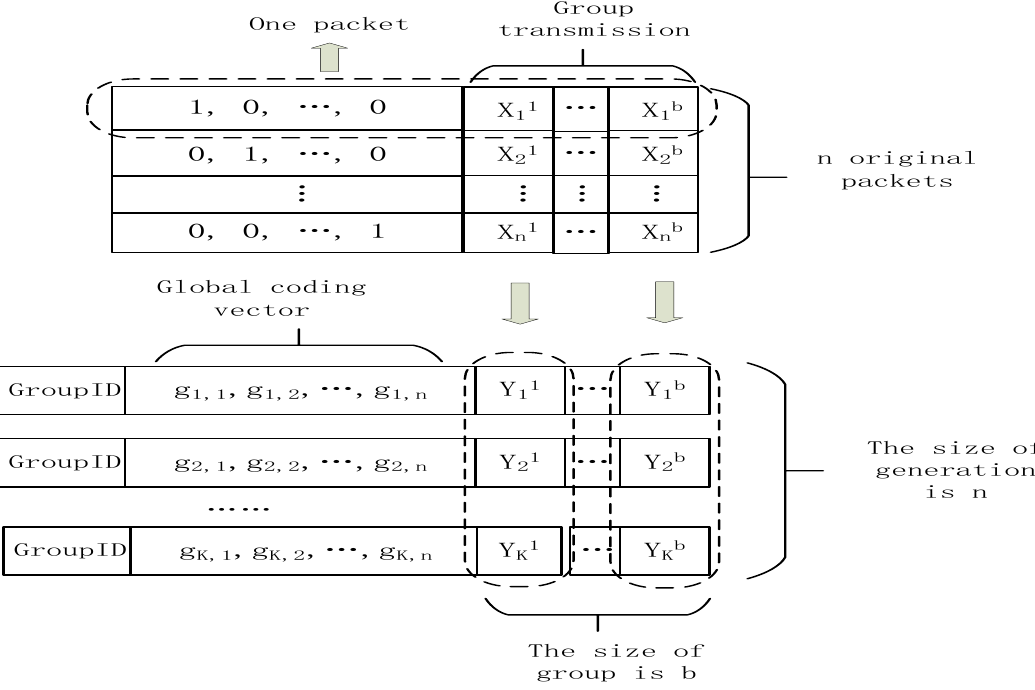
Figure 3. The packet format of practical network coding.